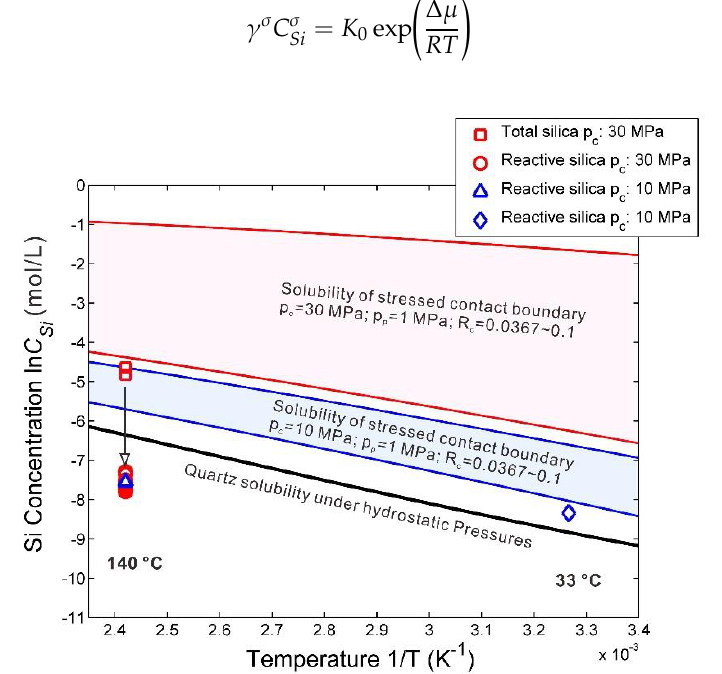
Figure 9. Si concentration as a function of inverse temperature 1 / T (K − 1 ). The dots indicate the respective measured Si concentrations under the corresponding P and T conditions (see chemical data in S2). The solubility of quartz in water at a hydrostatic pressure of 1 MPa (black line) is taken from Fournier and Potter II [30].